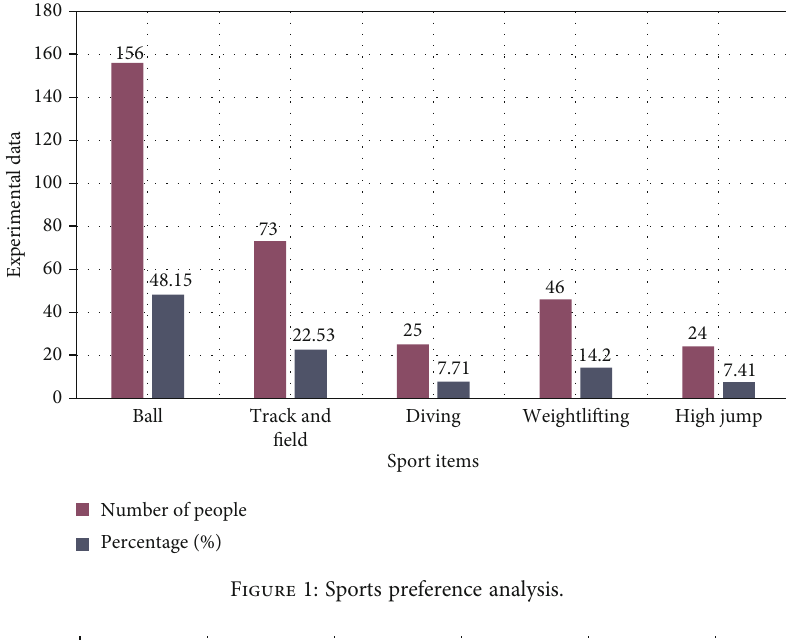
Figure 1: Sports preference analysis.